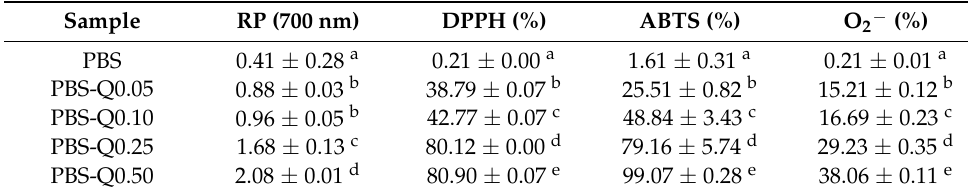
Table 1. Reducing power (RP) and free radical scavenging activity of PBS-based films. Sample RP (700 nm) DPPH (%) ABTS (%) O 2 − (%) PBS 0.41 ± 0.28